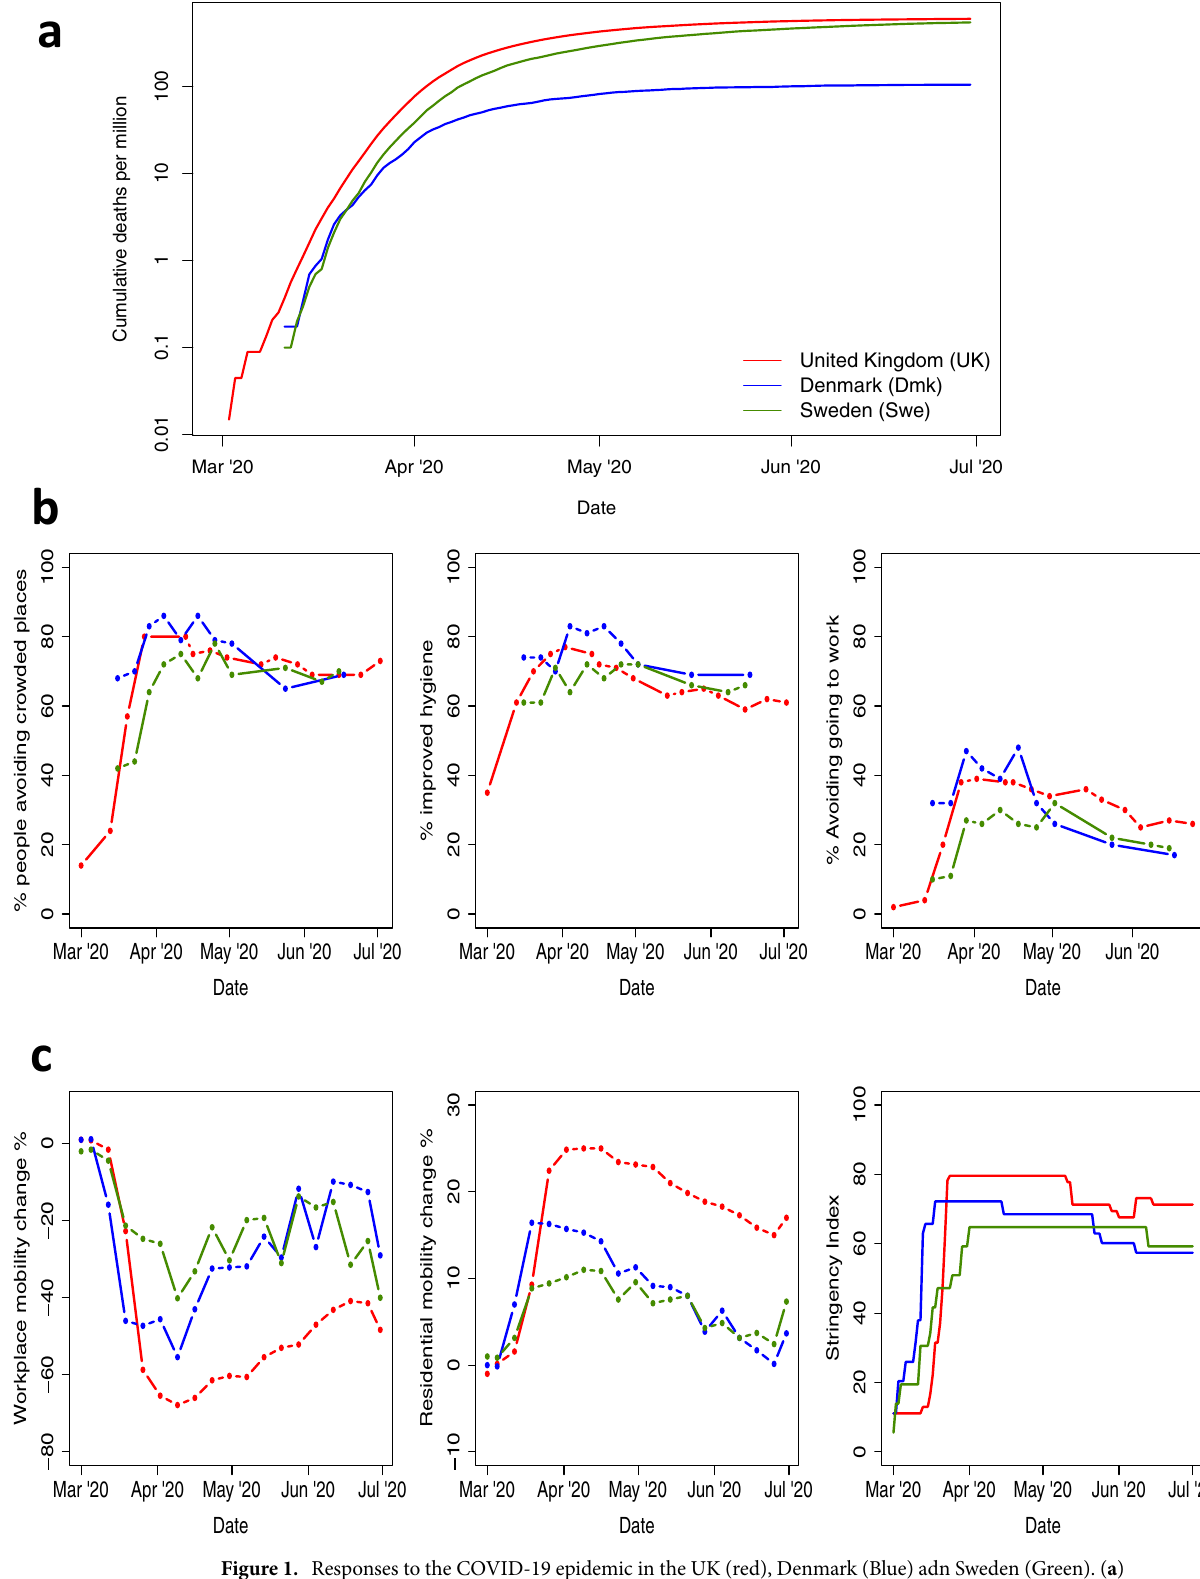
Figure 1. Responses to the COVID-19 epidemic in the UK (red), Denmark (Blue) adn Sweden (Green). ( a ) Cumulative laboratory-confirmed COVID-19 deaths per million by date of death. ( b ) Results of YouGov surveys of population behavioural responses to COVID-19 1 . The percentage of people: avoiding crowded public places (left); who report improved personal hygiene, e.g. frequent hand washing/using hand sanitiser (centre); avoiding going to work (right). ( c ) Google COVID-19 community mobility report data 2 giving change from baseline in mobility associated with workplaces (left), and in residential mobility (i.e. time spent at home) (centre). Right plots the OxCGRT COVID- 19 intervention stringency index 3 measuring the number of COVID-19 policies present at any given